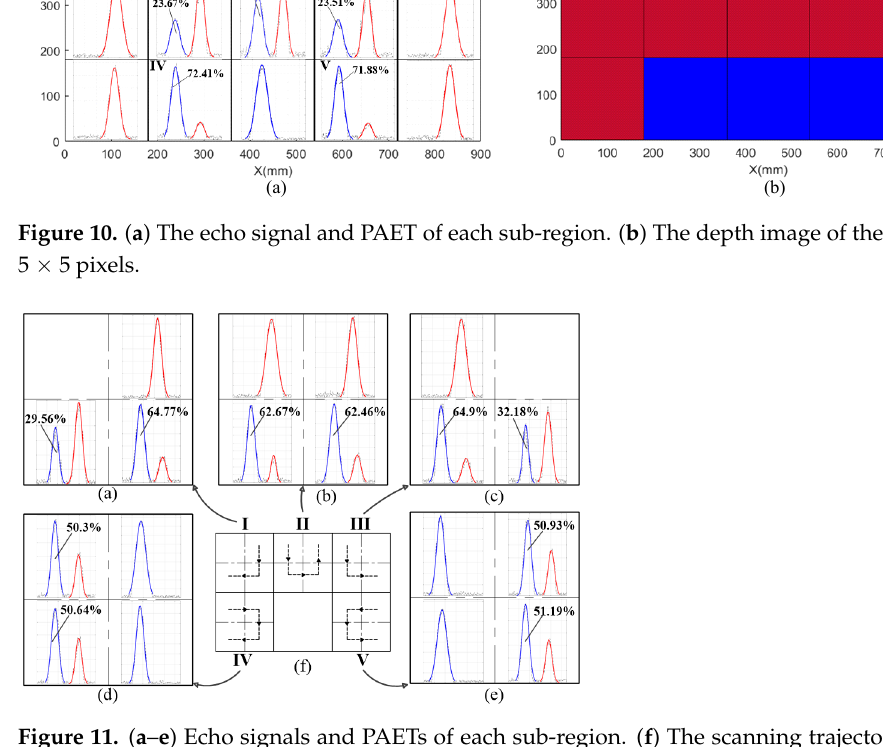
Figure 11. ( a – e ) Echo signals and PAETs of each sub-region. ( f ) The scanning trajectories of each sub-region in ( a – e ).